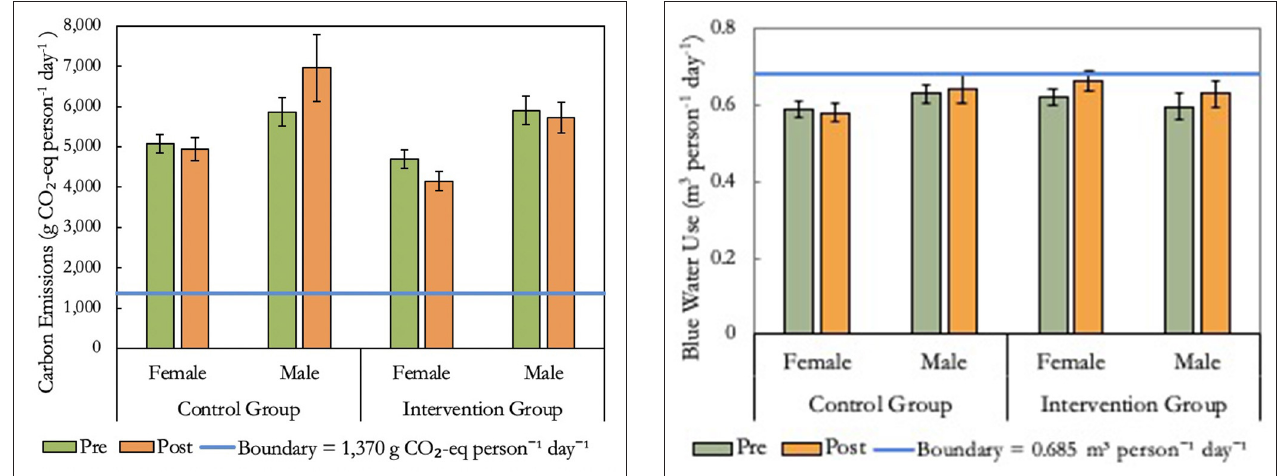
FIGURE 1 | Changes in dietary carbon footprint from baseline to follow up for female and male students in the intervention and control group. The per capita